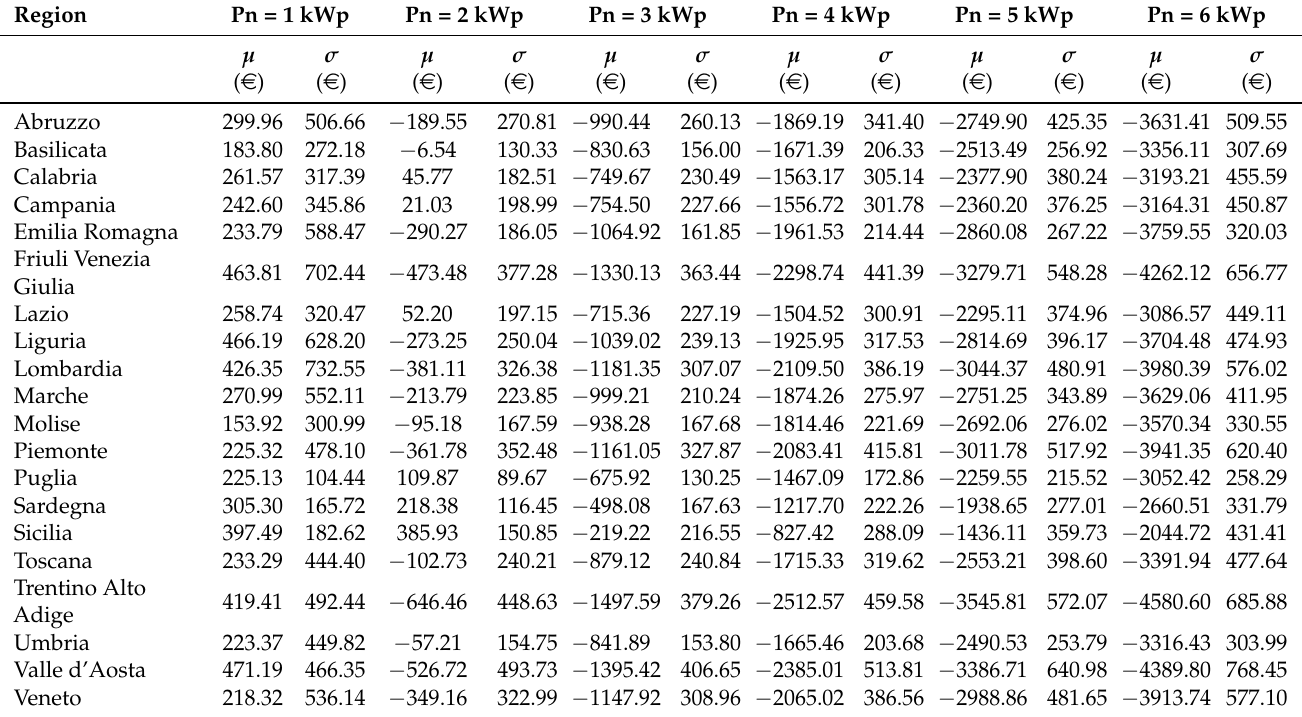
Table 8. Net Present Value (NPV) for E L = 2700 kWh without battery.